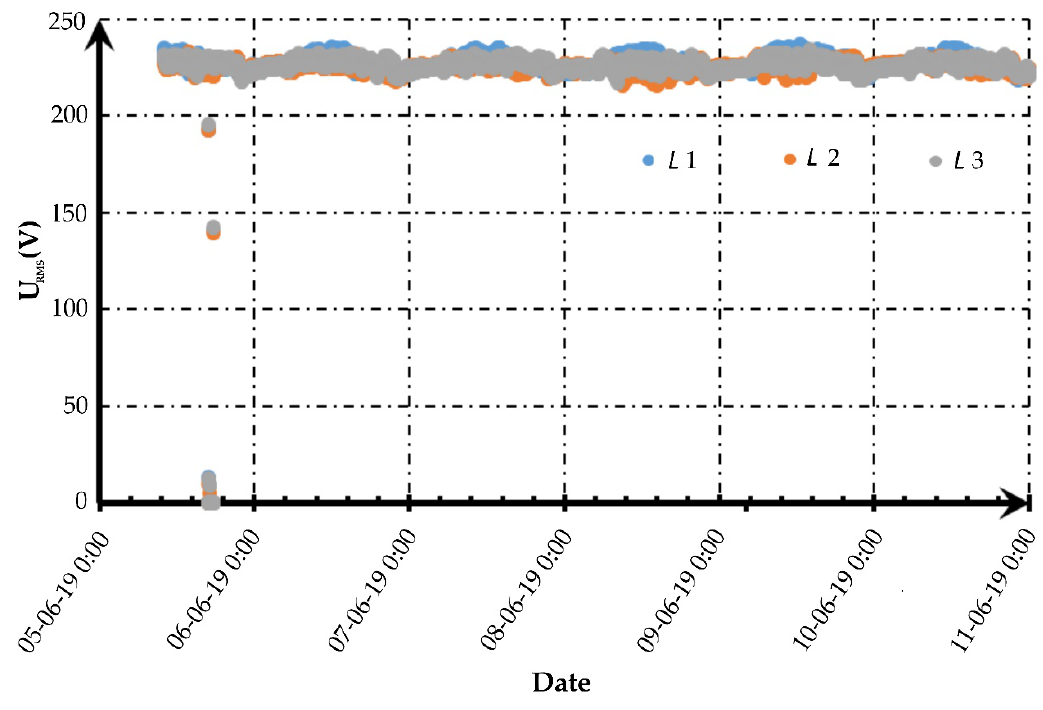
Figure 5. The RMS voltage measurements, U RMS for L 1, L 2, L 3.